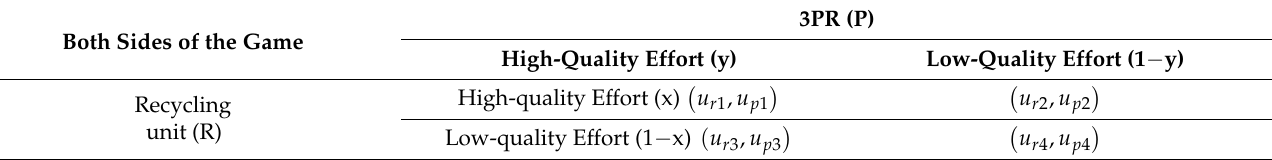
Table 5. Game profit matrix between the recycling unit and the 3PR in the second situation. Both Sides of the